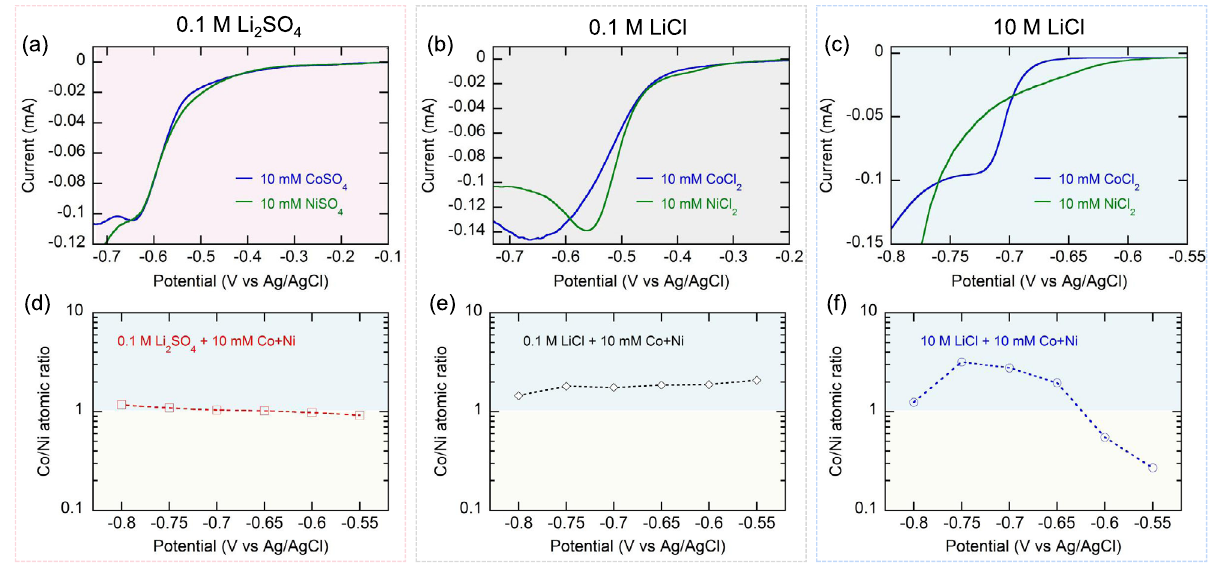
Fig. 2 Electrolyte control for selective electrodeposition of cobalt and nickel. Linear sweep voltammograms of a single metal salt of 10 mM Co(II) or Ni(II) in a 0.1 M Li 2 SO 4 , b 0.1 M LiCl, and c 10 M LiCl at a scan rate of 5 mV s − 1 . Surface Co/Ni ratios on the electrodeposit formed in the binary mixture of 10 mM Co(II) + Ni(II) in the background electrolyte of d 0.1 M Li 2 SO 4 , e 0.1 M LiCl, and f 10 M